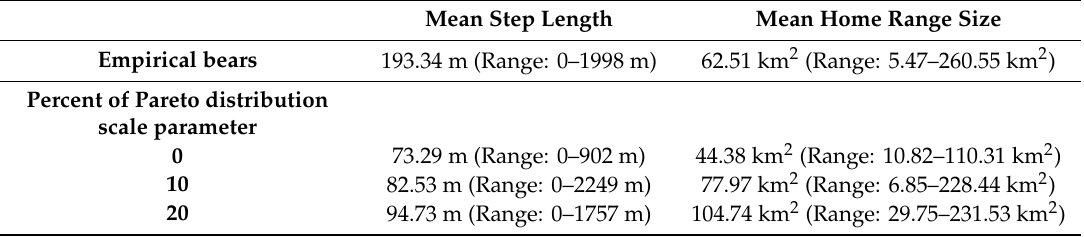
Table A2. Minimum convex polygon home range sizes and step lengths of our sample of empirical and simulated bears. For the simulated bears, we calibrated the individual-based movement models by increasing the scale of the Pareto distribution. We selected a 10% increase in the scale of the Pareto distribution for our final models since this resulted in the most realistic combination of home range sizes and step lengths for female black bears in